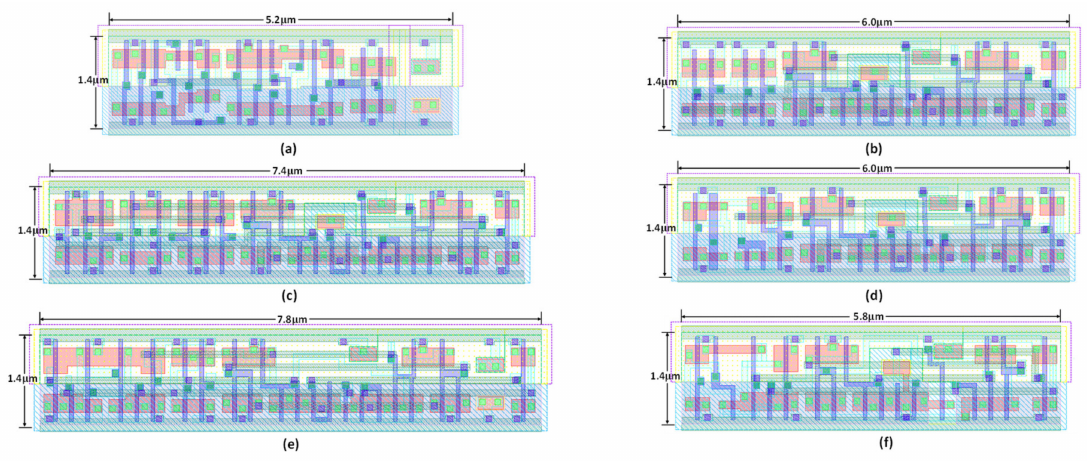
Figure 10. Layouts of ( a ) the master-slave flip-flop (MSFF); ( b ) the conventional SAFF; ( c ) Nikolic’s SAFF; ( d ) Lin’s SAFF; ( e ) Jeong’s SAFF; and ( f ) the proposed SAFF.